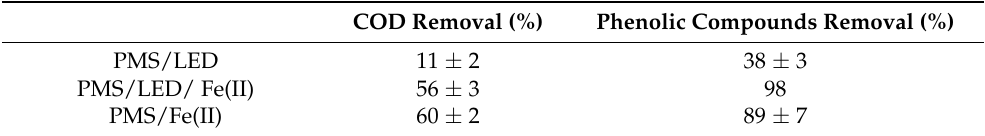
Table 3. PMS activated by LED influence on COD and phenolic compounds removal in 30 min for PMS/LED ([PMS] = 1600 mg/L and pH = 5), combination with Fe(II) (PMS/LED/ Fe(II); [PMS] = 1600 mg/L, [Fe 2+ ] = 700 mg/L and pH = 5) and PMS/Fe(II) ([PMS] = 1600 mg/L, [Fe 2+ ] = 700 mg/L and pH = 5). COD Removal (%) Phenolic Compounds Removal (%) PMS/LED 11 ± 2 38 ±